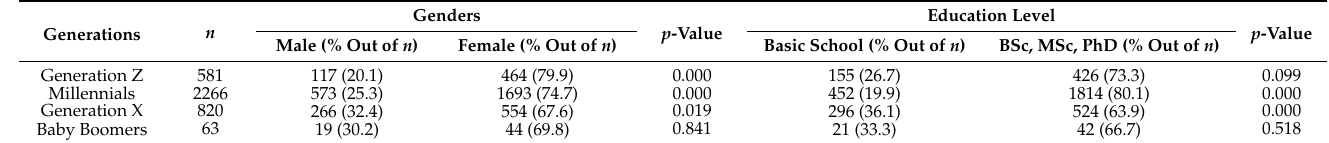
Table 3. Vaccinated people in each generation among genders and education level, n =